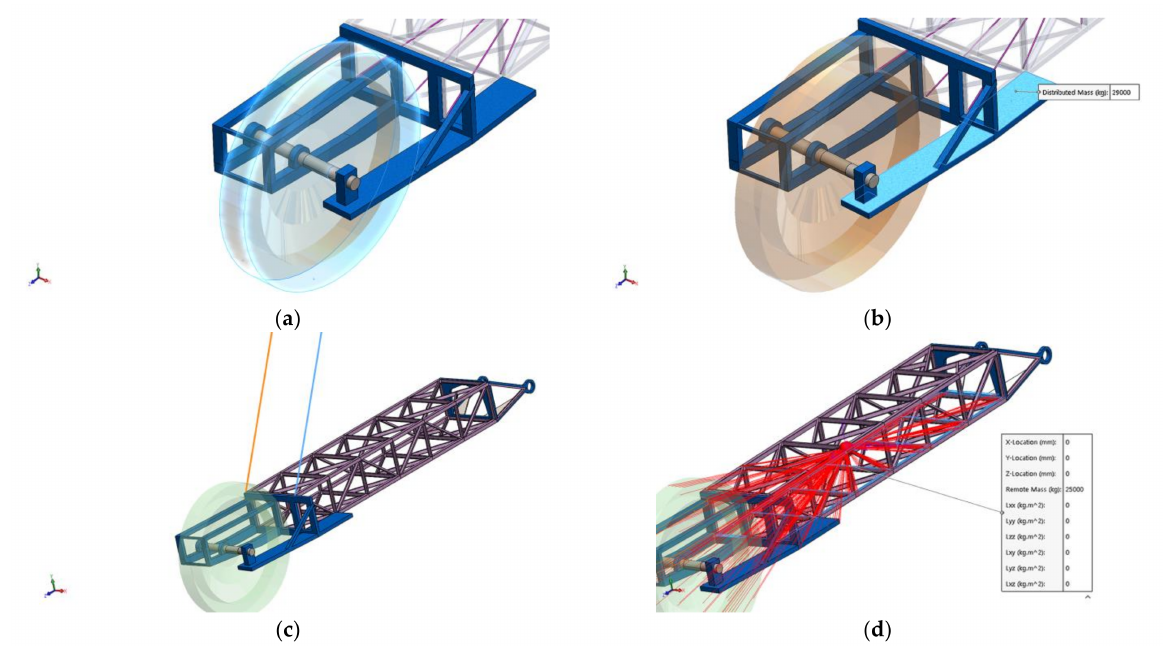
Figure 11. Static loads acting on the boom. Model and placement: bucket wheel weight ( a ); bucket wheel drive system weight ( b ); hoisting cables ( c ) and discharge conveyor belt ( d